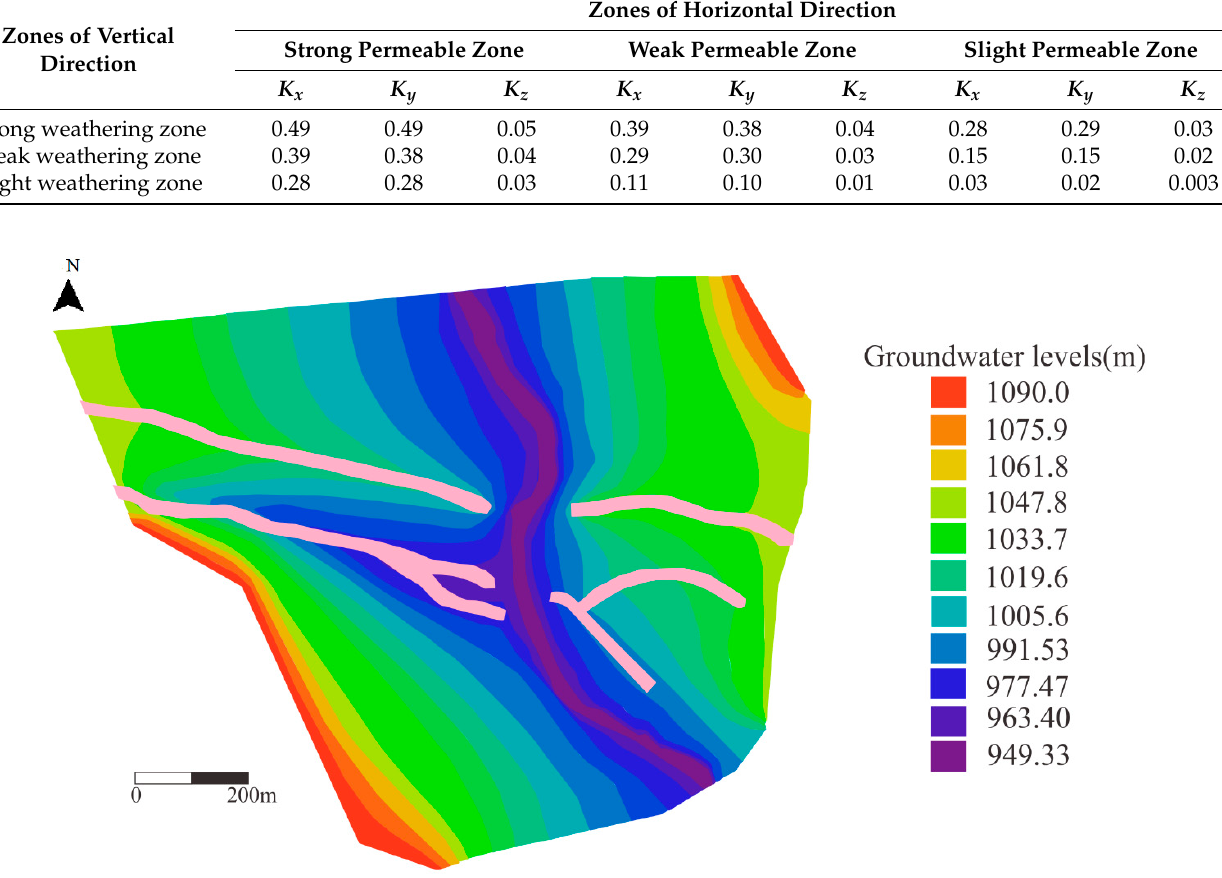
Figure 8. Contour map of groundwater level in the study area with five karst